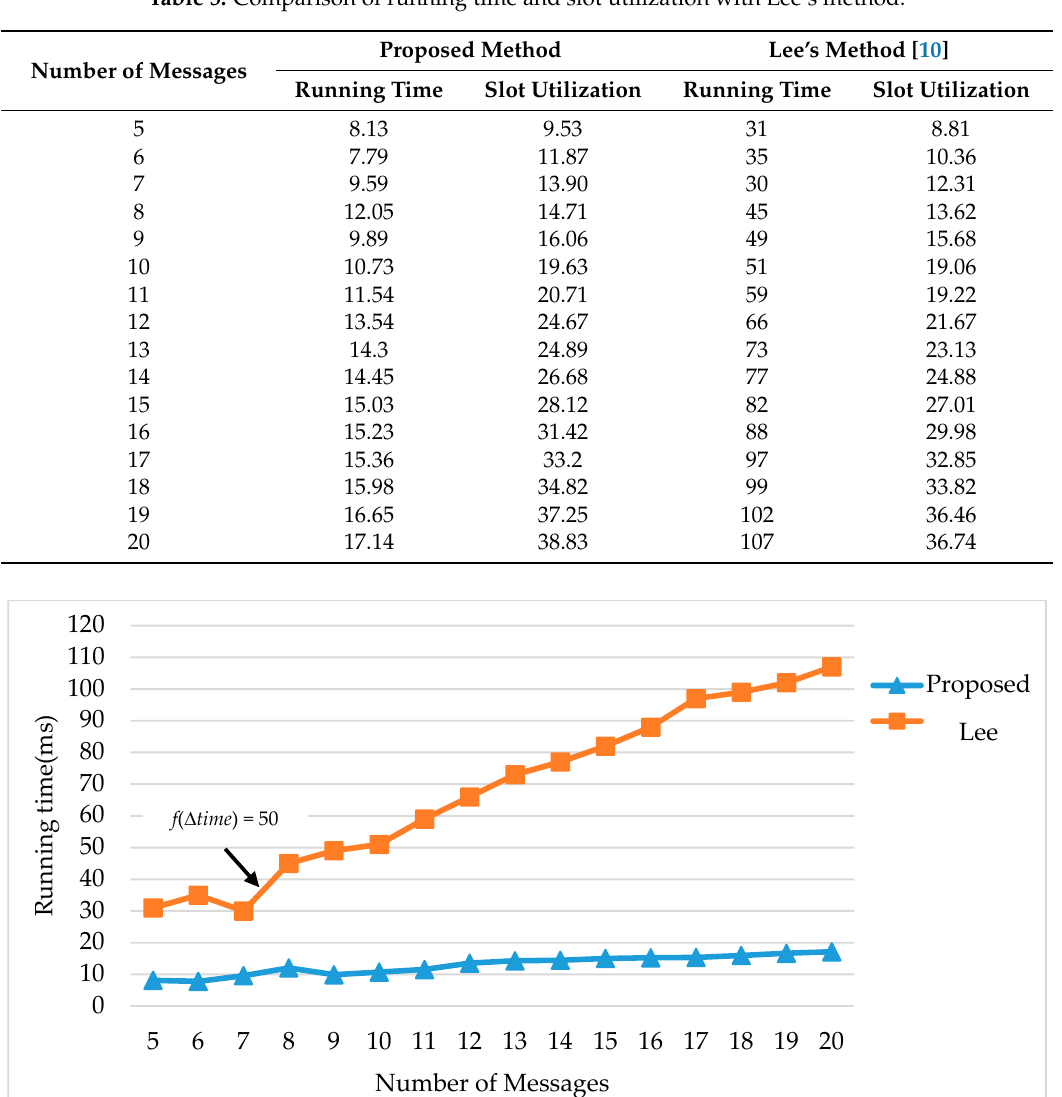
Table 5 . Comparison of running time and slot utilization with Lee’s method. Table 5. Comparison of running time and slot utilization with Lee’s method.